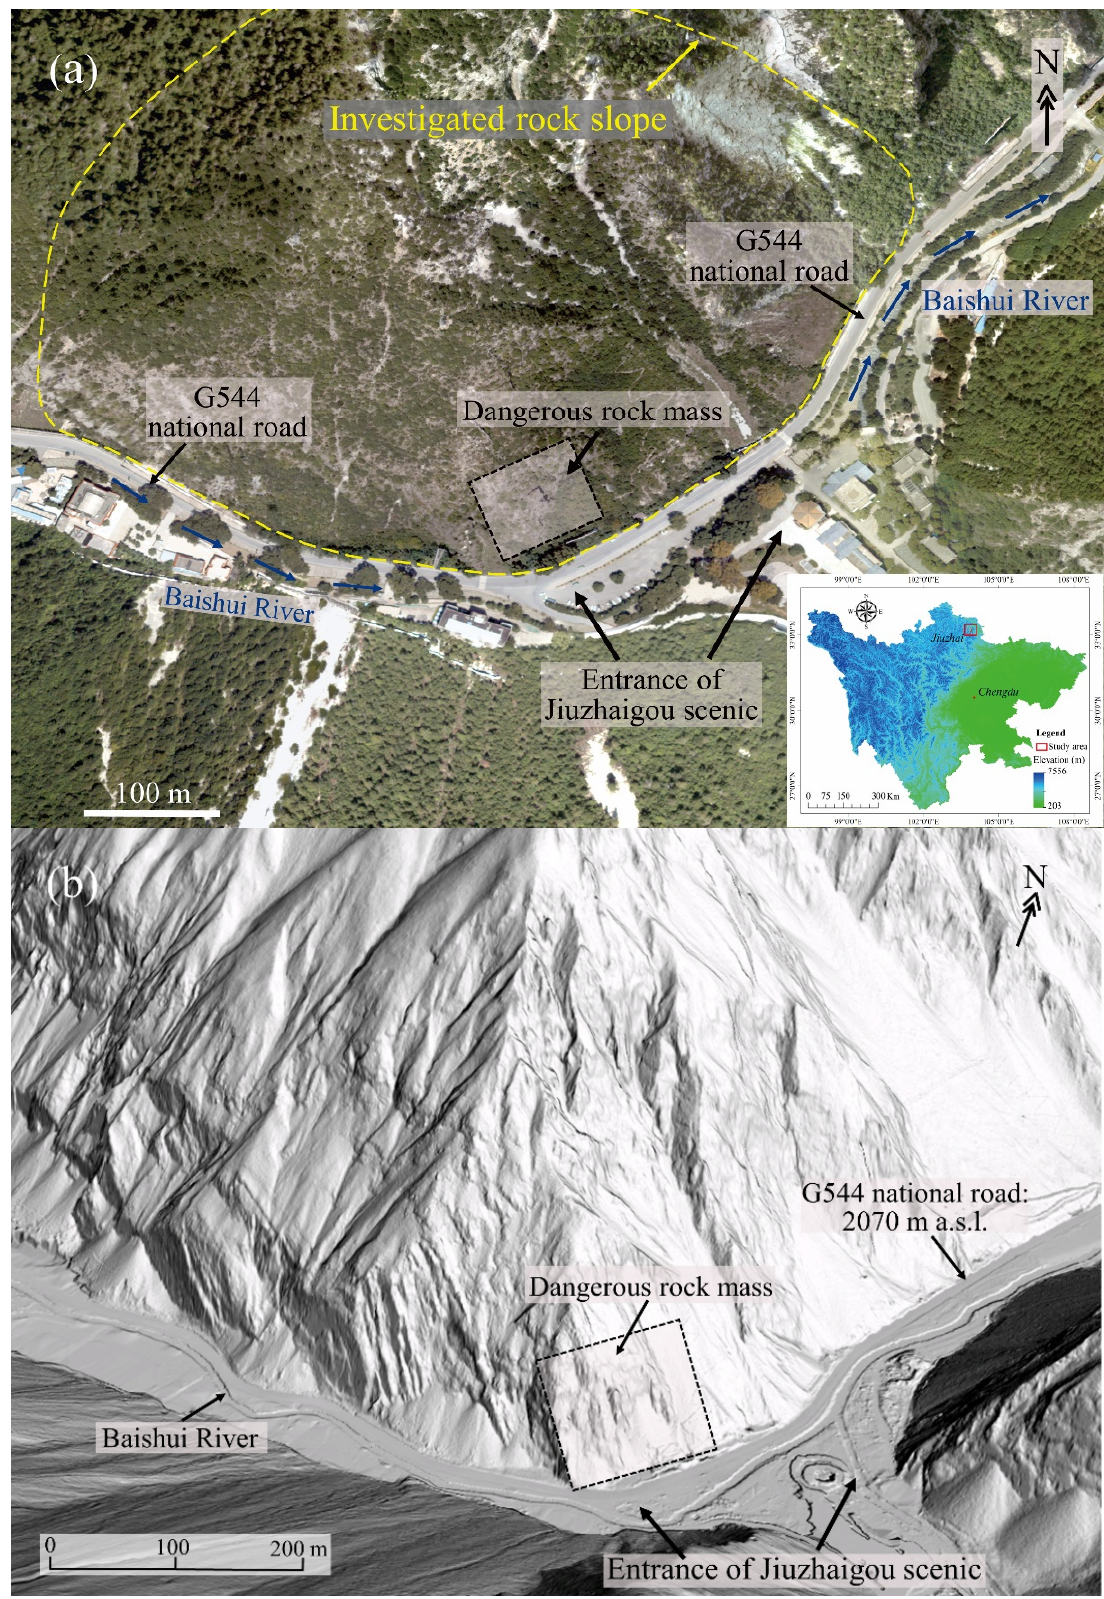
Figure 1. ( a ) Orthophoto (year 2018) of the investigated rock slope at the Jiuzhaigou Valley Scenic and Historic Interest Area; ( b ) three-dimensional digital terrain model (DTM) view of the study area.